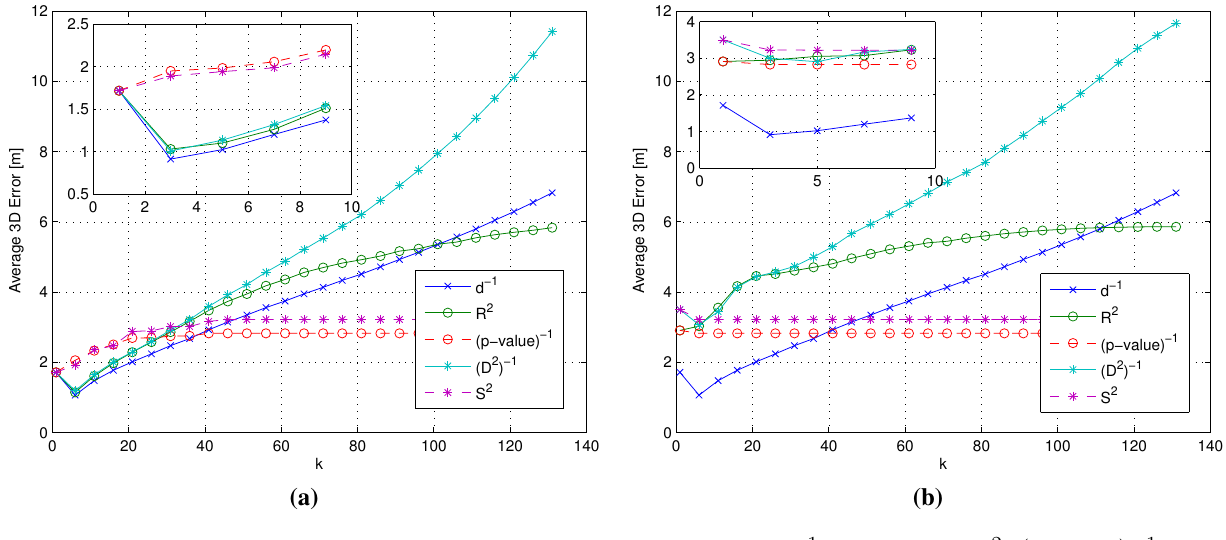
Figure 5. Average 3D error ¯ (cid:15) as a function of k . ( a ) ISIW ( d − 1 ) vs. ISRW ( R 2 , ( p -value ) − 1 , ( D 2 ) − 1 and S 2 ); ( b ) ISIW ( d − 1 ) vs. RSRW ( R 2 , ( p -value ) − 1 , ( D 2 ) − 1 and S 2